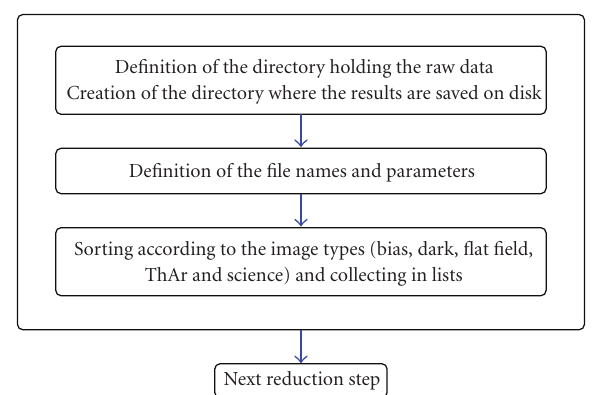
Figure 1: Flow chart with the main steps of the preparation of the reduction.